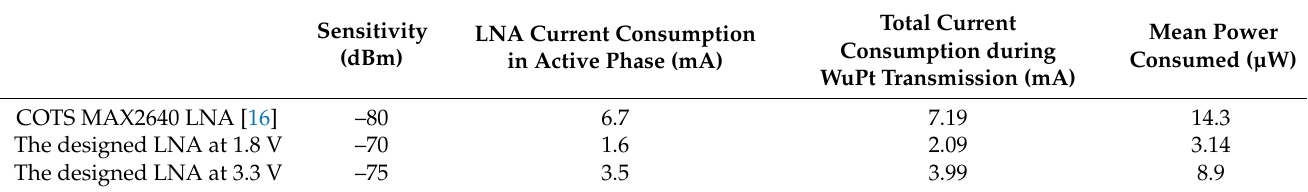
Table 4. Performances of designed LNAs integrated in duty-cycled wake-up